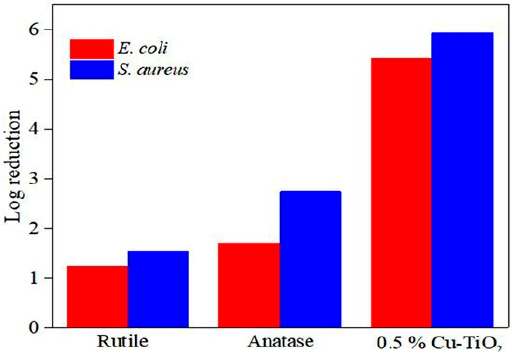
Figure 18. Photocatalytic bactericidal efficacy of 0.5% Cu/TiO 2 , pure anatase and rutile with E. coli and S. aureus upon visible light irradiation for 30 min. Reproduced with permission from [109]. Copyright MDPI, 2018.